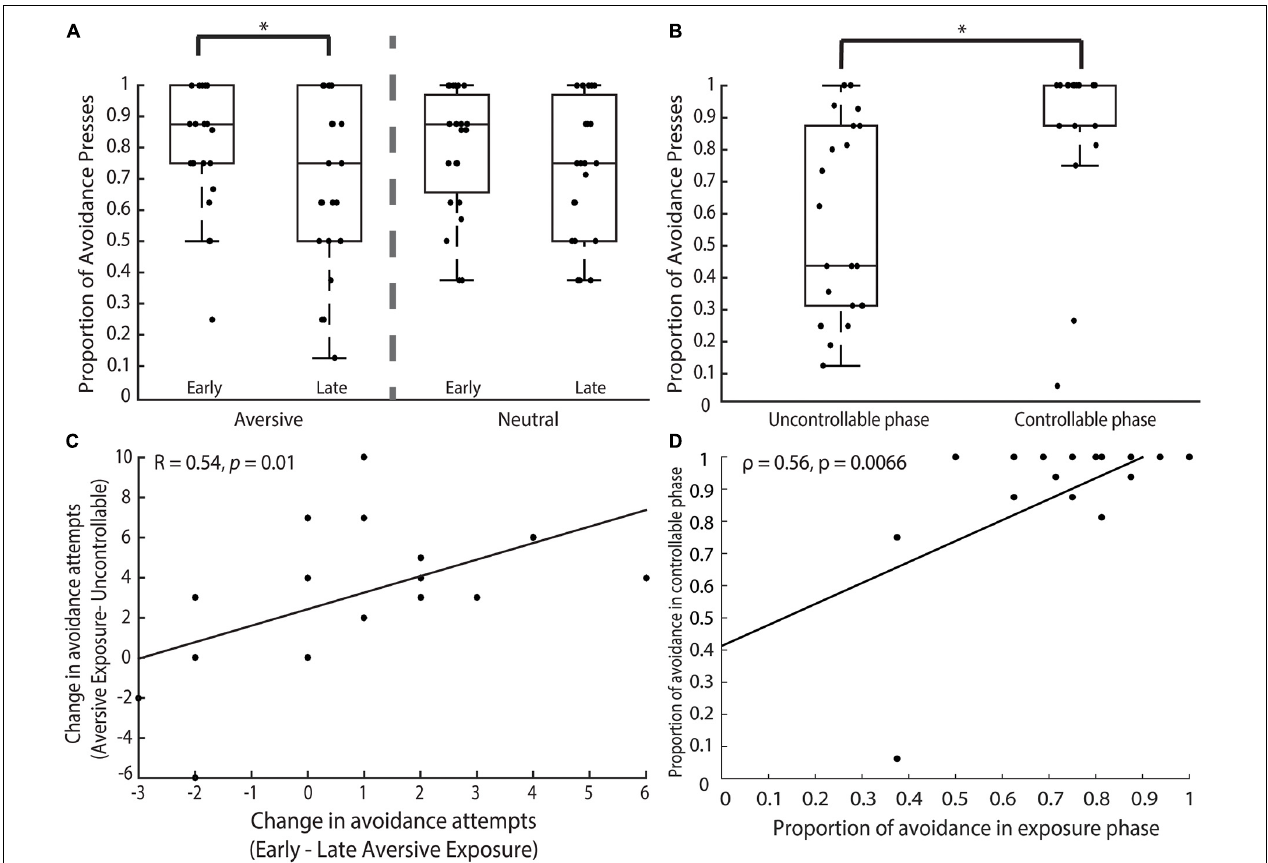
FIGURE 2 | Behavioral findings. (A) Exposure phase. Participants’ avoidance behavior revealed a significant main effect of time. Pairwise comparisons showed that this significant effect was driven by the marked decrease in AVOID button presses unilaterally present in the aversive but not neutral trials. (B) Uncontrollable and controllable phases . Participants significantly increased their avoidance behavior in the controllable phase when compared to the uncontrollable phase. (C) We examined participants’ changes in avoidance behavior between the early and late aversive exposure trials compared to the same changes in behavior across exposure (combined trials) and uncontrollable trials. We found that participants who showed greater decrease in their avoidance behavior from the early to late aversive exposure trials (i.e., larger x-axis) also showed greater decrease in their avoidance behavior from the aversive exposure to uncontrollable trials (i.e., larger y-axis). (D) We investigated the relationship between the proportion of avoidance behavior in the exposure and controllable phases and found that participants who made more avoidance presses in the exposure phase also subsequently made more avoidance presses in the controllable phase. Result remained significant even after removing outllier. * p <